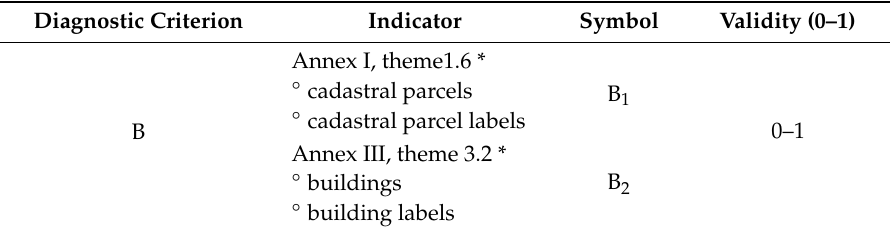
Table 3. Cadastral Data Profile.